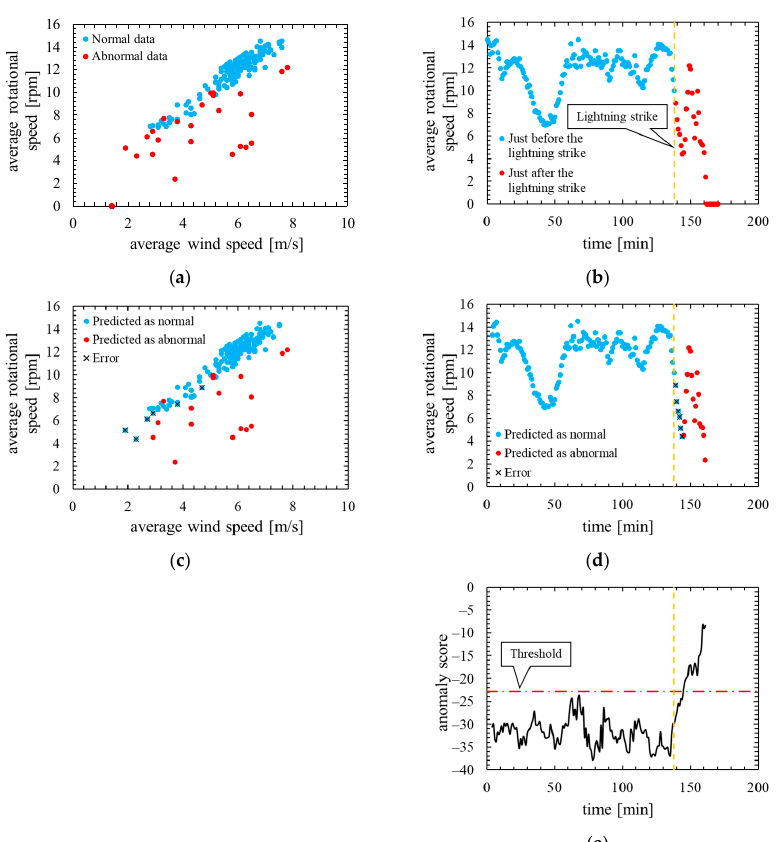
Figure 5. True label and assessment result of the model in which the number of mixture components K was determined based on BIC ( K = 29, threshold is 99th percentile’s value): ( a ) wind speed- rotational speed characteristic with true label; ( b ) time characteristics of rotational speed with true label; ( c ) wind speed rotational speed characteristic with predicted label; ( d ) time characteristics of rotational speed with predicted label; ( e ) time characteristics of anomaly score.